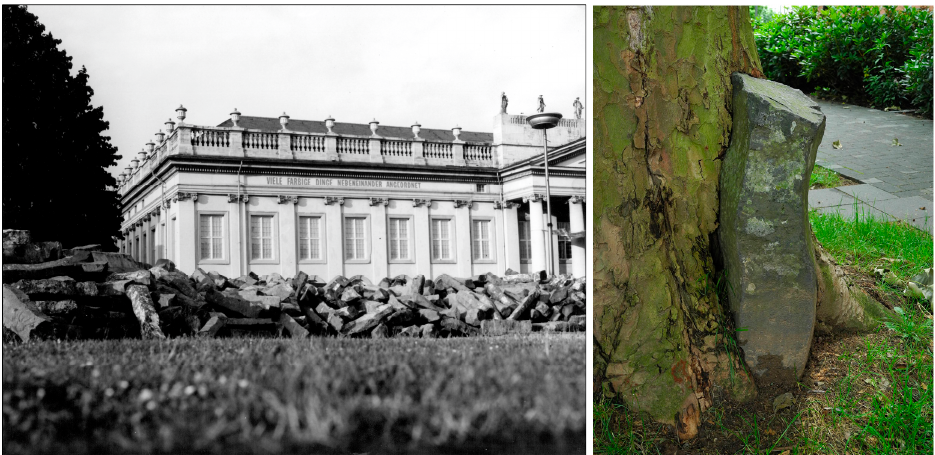
Figure 2. ( Right ), Basalt steles were in front of the Museum Fridericianum [47]. ( Left ), an oak planted during the 7000 Eichen is now embedding the basalt stele [48].